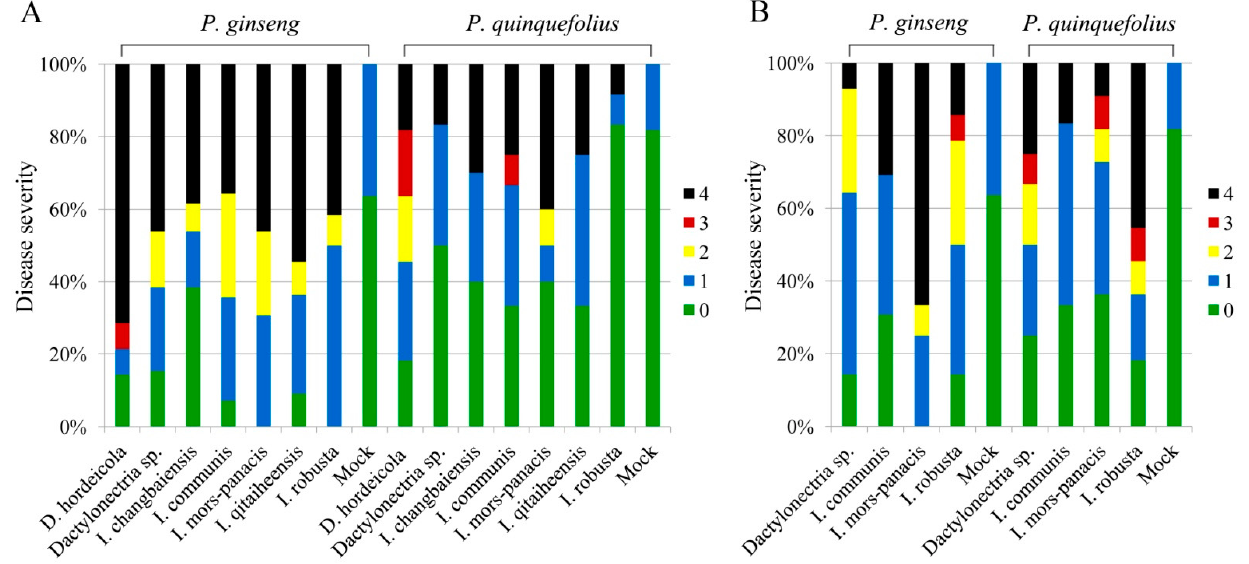
Figure 2. Disease severity of Cylindrocarpon -like fungi on Panax ginseng and P. quinquefolius roots. ( A ): Inoculation with isolates from P. ginseng ; ( B ): Inoculation with isolates from P. quinquefolius . Disease symptoms were scored using a disease index ranging from 0 to 4, measured by the lesion area out of the whole root surface: 0, no symptoms; 1, ≤ 1/10; 2, >1/10 and ≤ 1/3; 3, >1/3 and ≤ 2/3; 4, >2/3.